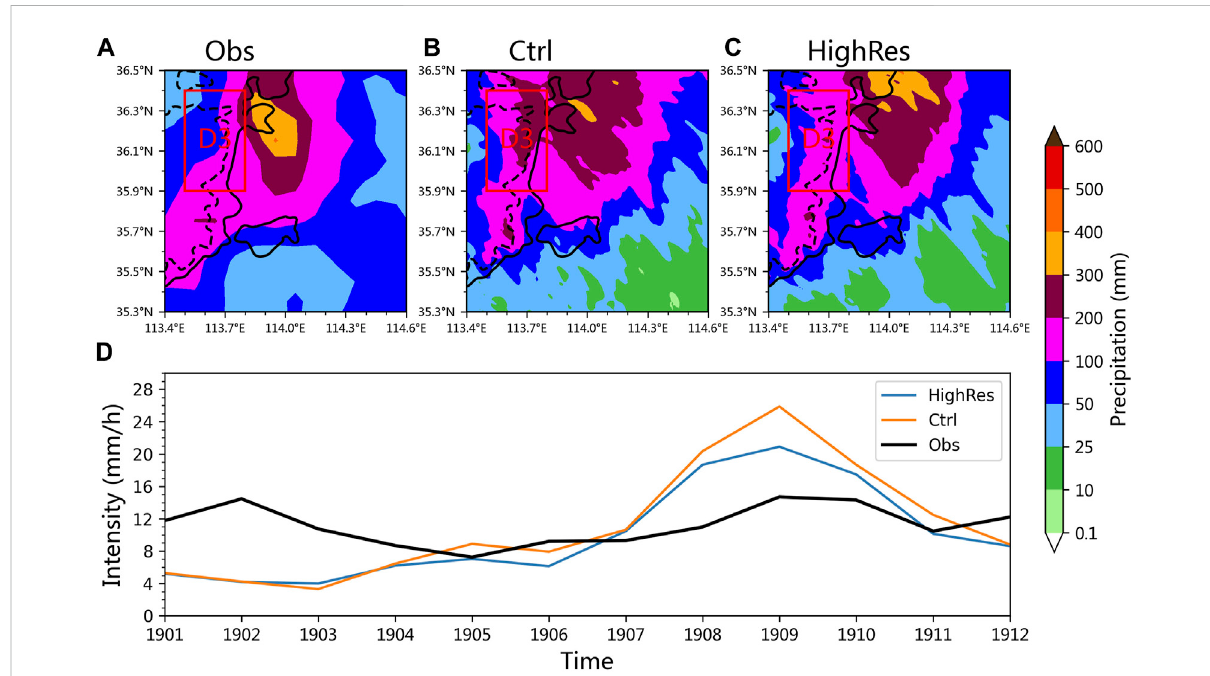
FIGURE 5 (A) Observationalprecipitationandsimulatedprecipitationin (B) Ctrl and (C) HighRes experimentsfrom0000to1200UTCon19July2016.The black solid line denotes the 500 m contour line, and the black dotted line denotes the 1000 m contour line. (D) Time series of area-averaged hourly precipitation intensity in the area D1 from 0000 UTC on 19 July 2016 to 0000 UTC on 20 July